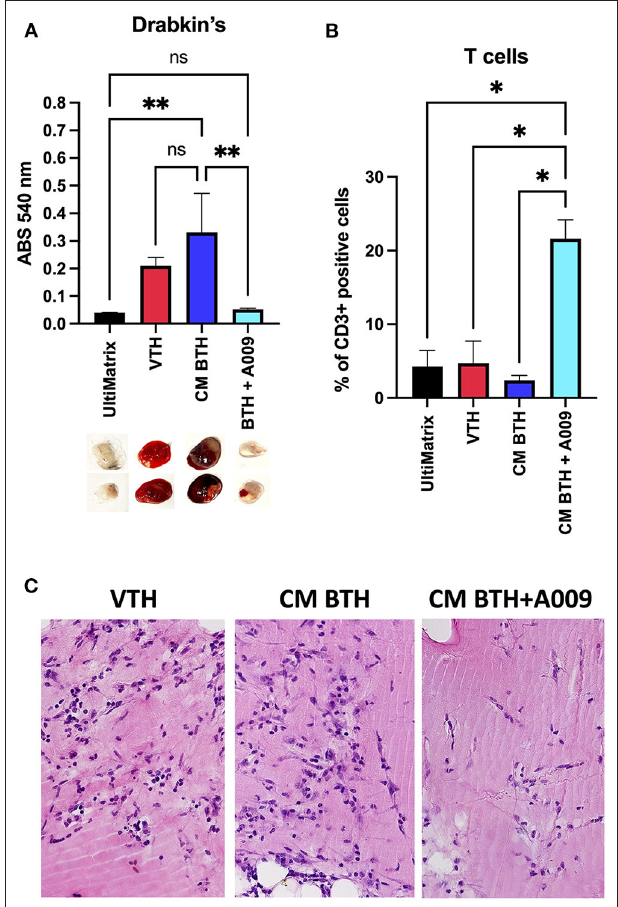
FIGURE 1 | Effects of the A009 extract on angiogenesis and immune cell infiltration in vivo . The effects of the A009 on angiogenesis, induced by CM of BC cell lines, and immune cell infiltration in vivo , was evaluated by the UltiMatrix Matrigel sponge assay. (A) Determination of the hemoglobin content in the excised pugs, using the Drabkin’s assay and visual inspection of excised pellets; (B) determination of T-cell infiltration, detected as CD3 + cells, in the plugs by flow cytometry. Data are shown as mean SEM, one-way ANOVA, ± * p < 0.05 and ** p < 0.01. VTH (vascular endothelial growth factor (VEGF), tumor necrosis factor (TNF)- α , heparin), CM BTH (CM BT549 heparin), A009 + extract. Hemoglobin is decreased by A009 and T-cell infiltrates are increased. (C) Histological examination of pellets. Sections of paraffin embedded plugs were stained with hematoxylin eosin. VTH: VEGF-TNF- α -heparin containing UltiMatrix show angiogenesis. Pellets with BTH conditioned media show angiogenesis with many vessels. Pellets with A009 in addition to BTH CM show reduced angiogenesis with few